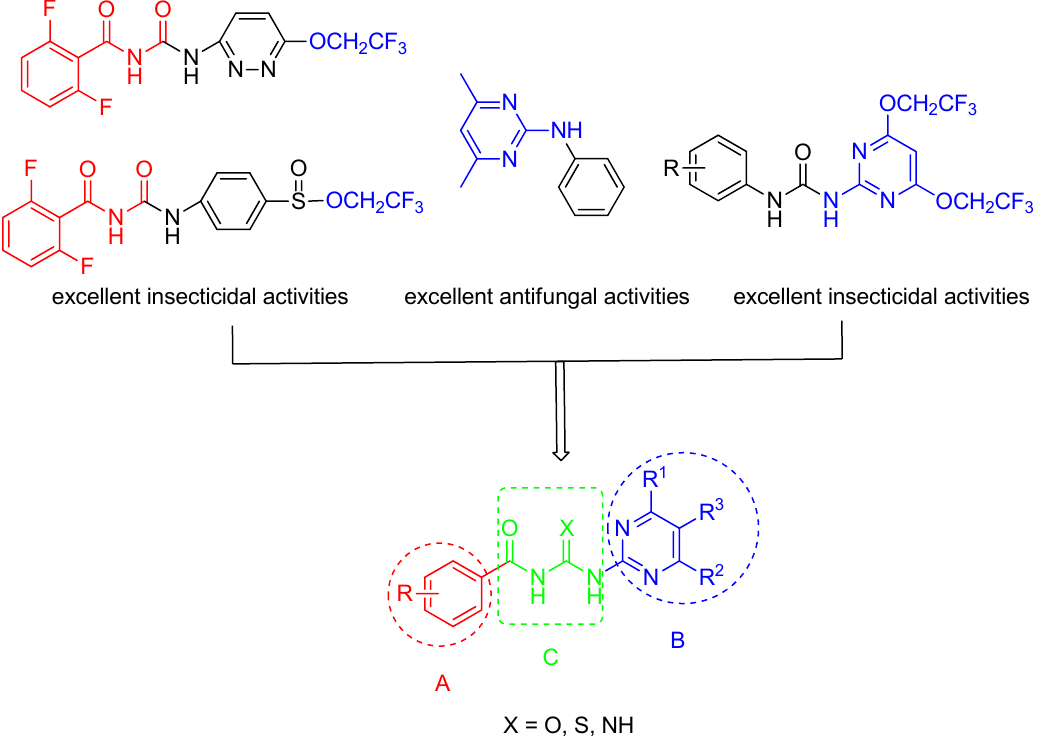
Figure 3. Design strategies of the target benzoylpyrimidinylurea derivatives.